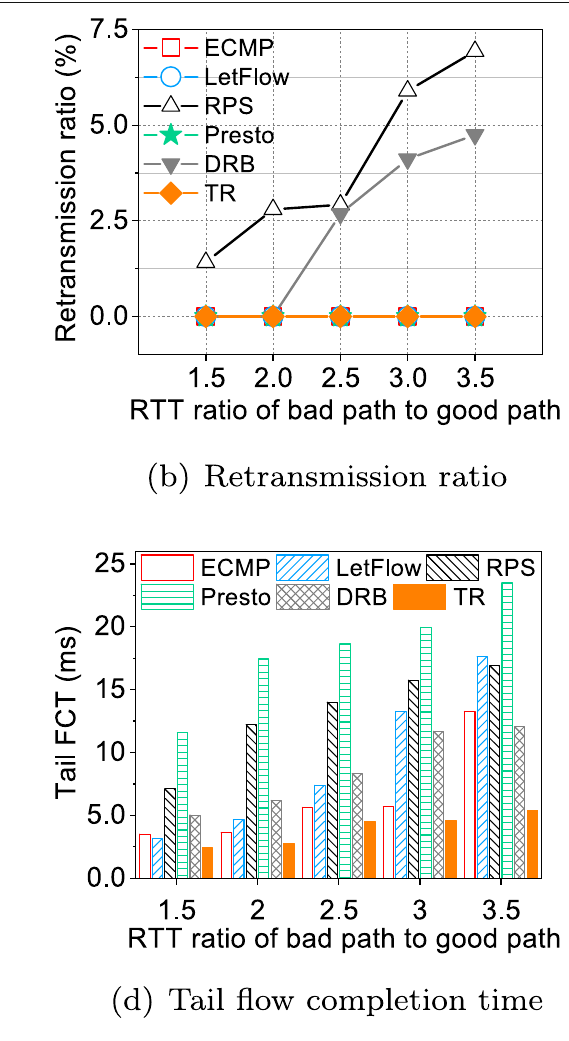
Fig. 7 The performances of short flows